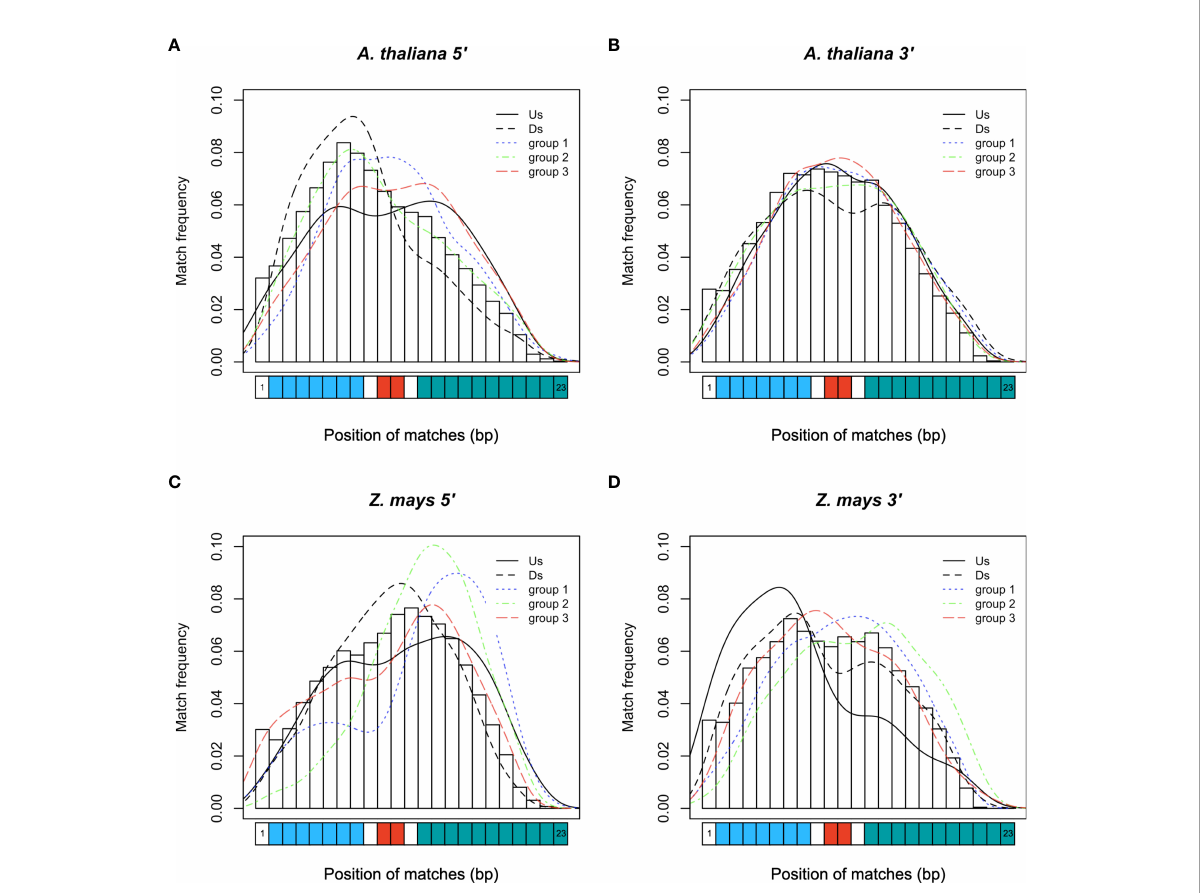
FIGURE 5 Frequency of miRNA bases covered by miPLMs. (A) Frequencies for the 5 ’ -miPLMs and the (B) 3 ’ -miPLM of A. thaliana . (C) Frequencies for the 5 ’ -miPLMs and the (D) 3 ’ -miPLM of Z. mays . The color curves indicate the densities of matched-ribonucleotide positions depending on whether the miPLM that matches belongs to one of the PLM groups (groups 1, 2 or 3) or is located upstream (Us) or downstream (Ds) of these groups. The blue, red and green rectangles on the abscissa represent the bases of the 5 ’ - seed region, the cleavage site and the 3 ’ -compensatory end of the miRNA,